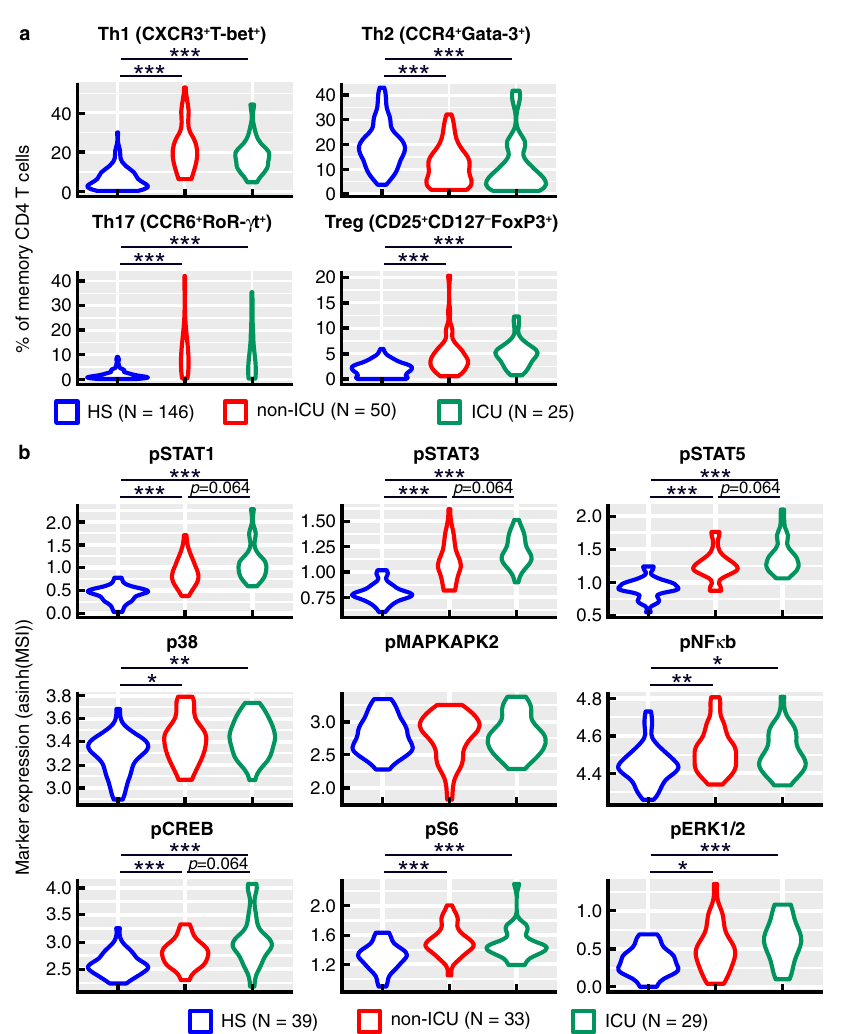
Fig. 1 Distribution of CD4 T cell lineage and phosphoprotein signaling pro fi les in non-ICU and ICU COVID-19 patients. a Frequencies of Th1 (CXCR3 + T-bet + ), Th2 (CCR4 + Gata-3 + ), Th17 (CCR6 + RoR- γ t + ) and Treg (CD25 + CD127-FoxP3 + ) CD4 T cell sub-populations in healthy subjects ( N = 146), non-ICU ( N = 50) and ICU ( N = 25) patients. b Mean signal intensity of ex vivo phospho-STAT1 (pSTAT1), pSTAT3, pSTAT5, p38, pMAPKAP2, pNFkB, pCREB, pS6 and pERK1/2 in healthy subjects ( N = 39), non-ICU ( N = 33) and ICU ( N = 29) patients. Blue plots correspond to healthy subjects (H.S), red plots correspond to non-ICU patients and green plots correspond to ICU patients. Black stars indicate statistical signi fi cance between ICU or non-ICU patients and healthy subjects. Statistical signi fi cance ( P values) was obtained using two-sided Kruskal – Wallis test, using a Bonferroni correction. * P < 0.05; ** P < 0.01; *** P < 0.001. Exact P values are available in Source Data fi